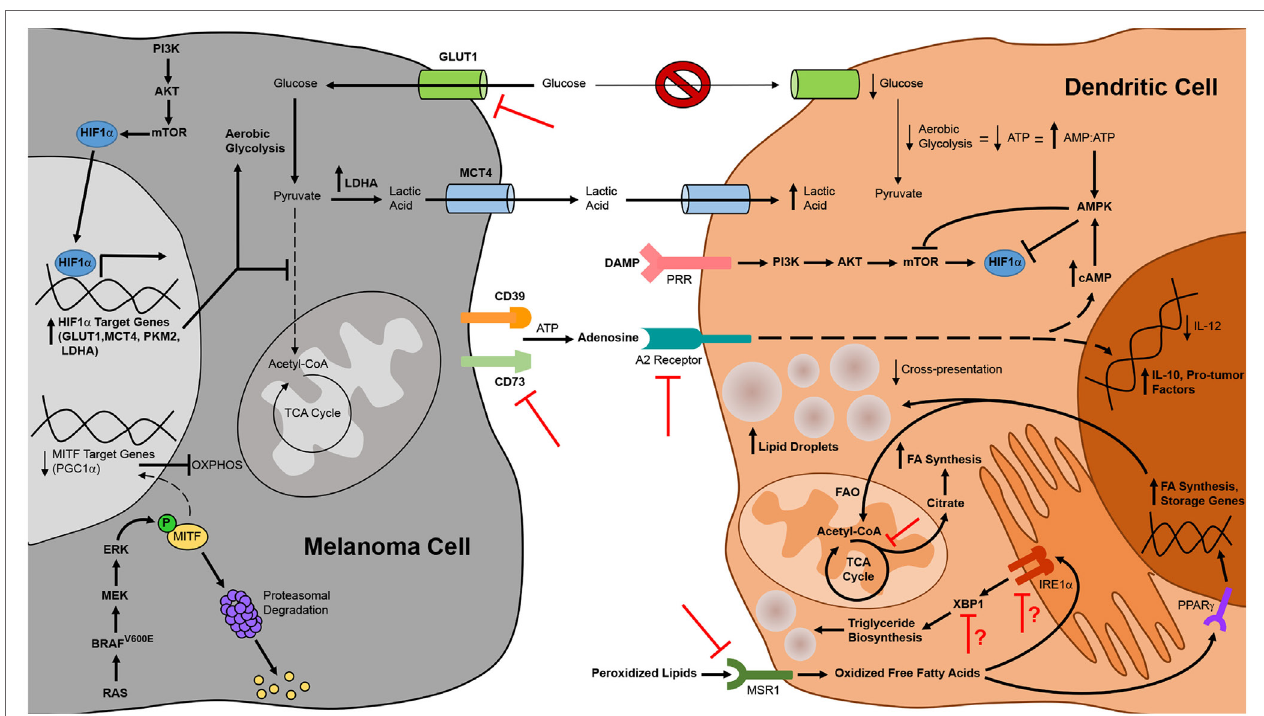
FiGURe 3 | Alterations to tumor cell and dendritic cell (DC) metabolism in the context of melanoma and therapeutic strategies to overcome metabolic suppression of melanoma-associated DC. DC function in the context of melanoma is compromised by constraints on metabolic pathways essential to DC maturation and activation. Metabolic suppression of DC in the tumor microenvironment arises from nutrient depletion and the buildup of toxic waste that results from metabolic rewiring of melanoma cells for aerobic glycolysis. Uptake of peroxidized lipids within the tumor microenvironment also promotes DC dysfunction, leading to an accumulation of oxidized lipids in DC that impairs cross-presentation of tumor antigen. Additionally, tumor cell release of immunosuppressive metabolites such as adenosine that signal through DC inhibit the antitumor function of these cells. Mechanistic insights into these phenomena have identified novel targets for therapies designed to interfere with metabolic pathways in melanoma cells or to prevent tumor-altered metabolism of melanoma-associated DC. Pharmacologic interventions or tissue-specific gene-silencing approaches that target factors upregulated by melanoma cells have direct antitumor effects and are also likely to improve DC function indirectly by creating a more hospitable metabolic microenvironment. Similarly, DC-targeted delivery of therapeutics that prevent uptake of suppressive metabolites or that block metabolic pathways associated with tolerogenicity can improve the immunostimulatory function of endogenous DC, and manipulation of exogenous DC to resist the induction of metabolic suppression can improve the efficacy of DC vaccines. Bold arrows and type designate metabolic pathways, metabolites, intermediates, and processes that are elevated in melanoma cells and tumor-altered DC. Arrows and type not in bold represent those that are downregulated in these cells. Red inhibition symbols highlight proteins and metabolic pathways that have been successfully targeted in melanoma cells and DC in preclinical studies, as described in the text. Red inhibition symbols with red question marks indicate targets that have been associated with both immune activating and immune suppressing functions in different models and whose inhibition may therefore be appropriate only in certain contexts, as is discussed in more detail in the